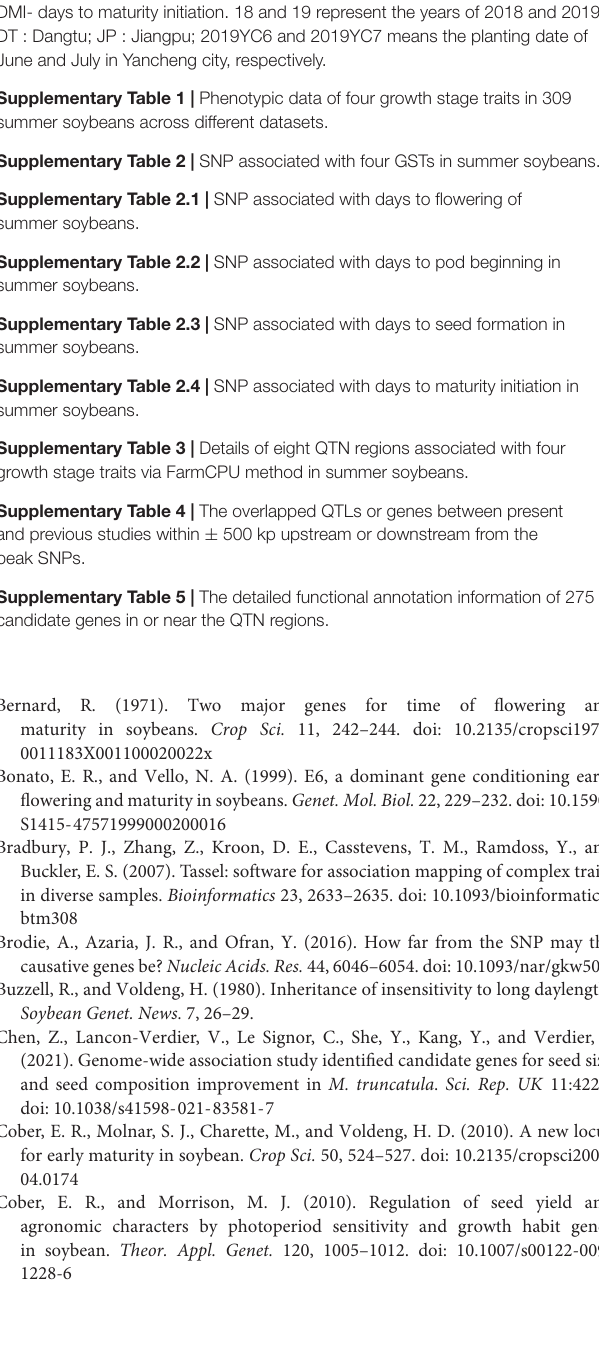
Supplementary Figure 3 | Phenotypic variation between cultivars carrying different alleles of the QTNs significantly associated with four growth stage traits in various environments. The box plot shows the significant difference of days to flowering, pod beginning, seed formation and maturity initiation of the cultivars carrying two alleles of the QTNs. The significant QTNs were Gm02_150932 , Gm06_16710123 , Gm06_19332290 , Gm06_21072696 , Gm11_15963231 ,